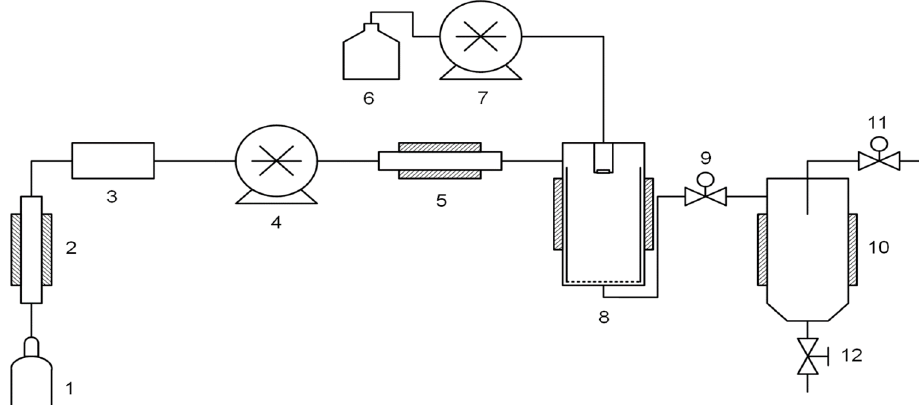
Figure 2. Schematic representation of the supercritical antisolvent (SAS) apparatus adapted from [36]. 1 is a CO 2 container; 2 is a cooler; 3 is a flowmeter; 4 is a CO 2 pump; 5 is a heater; 6 is a polymer solution; 7 is a solution pump; 8 is a precipitator; 9 is an automatic back pressure regulator; 10 is a separator; 11 is a manual back pressure regulator; 12 is a drain valve.